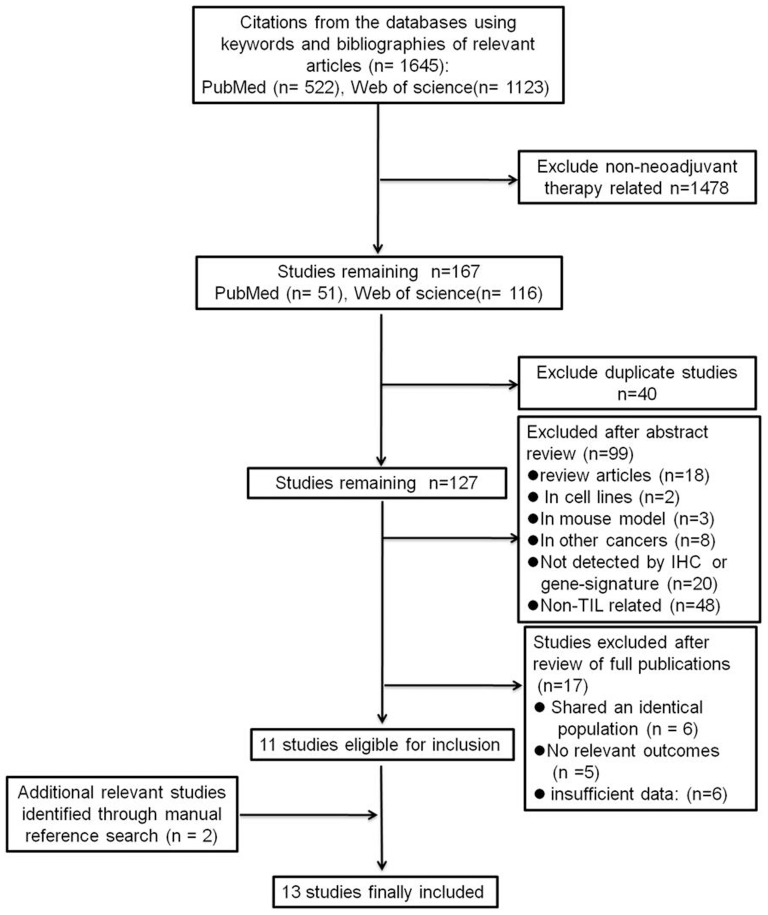
Flow chart for the selection process of eligible publications.